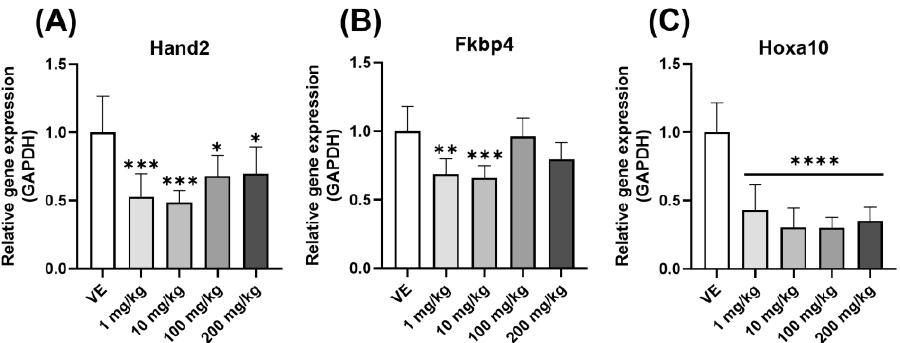
Figure 9. Changes in the expression levels of genes associated with implantation in the uterus when exposed to D5. Gene expression confirmed by qPCR in the uterus of rats exposed to D5 for four weeks: ( A ) Hand2 expression level; ( B ) Fkbp4 expression level; ( C ) Hoxa10 expression level. The values are expressed as means ± SD. * p < 0.05, ** p < 0.01, *** p < 0.001 and **** p < 0.0001 vs. vehicle. VE—vehicle, N = 9~10.